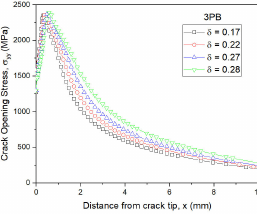
Figure 6. Opening stress distributions of the 3PB specimens under di ff erent CTODs.